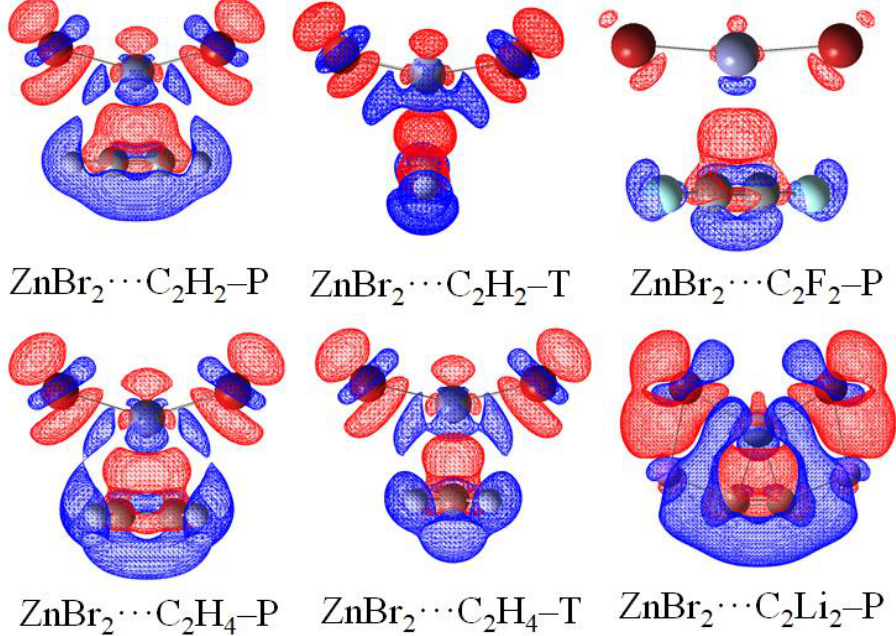
Figure 5. Electron density shifts of selected binary complexes (iso = ± 0.0008). Red regions indicate increased electron density, while blue regions represent decreased electron density.